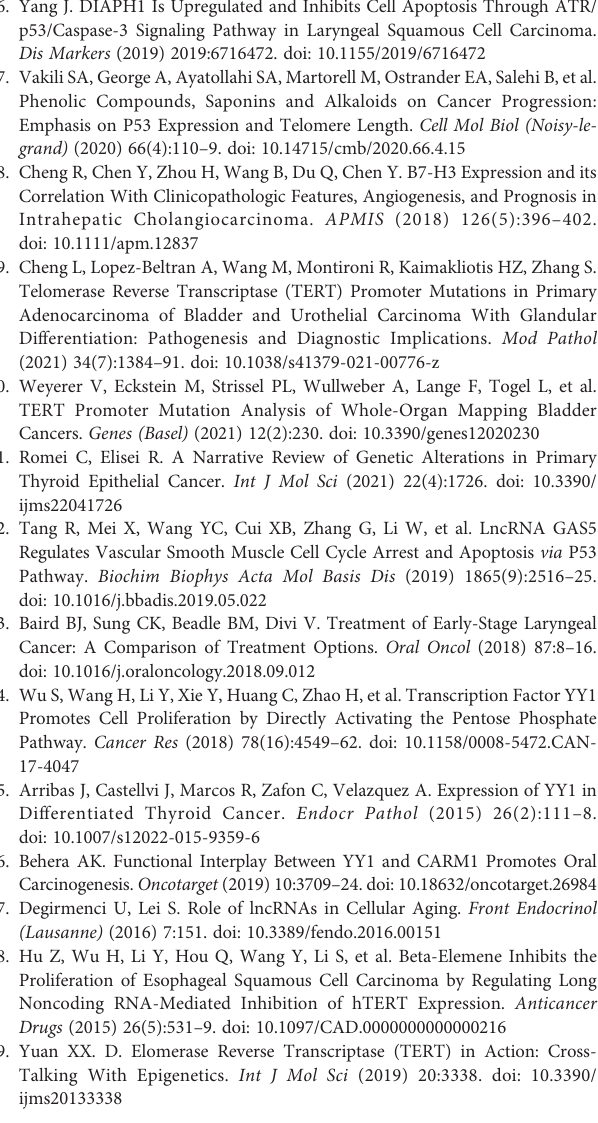
Supplementary Figure 3 | Veri fi cation of the correctness of TERT antibody. (A) RT-qPCR used to detect the expression level of TERT mRNA, * indicates p < 0.05 compared with NC. (B) The expression of TERT protein detected by Western blot. Supplementary Figure 4 | Co-IP results. (A) The interaction between GAS5, p300 and p53. (B) interaction between p300 and p53 after overexpression of YY1 and cGAS5. Supplementary Figure 5 | Representative images of FISH and Q-FISH assays. A, Subcellular localization of YY1 (green) and GAS5 (red) determined by FISH assay. Blue indicates DAPI staining. B, Telomere length of cells measured by Q- FISH. Blue indicates nucleus, red indicates telomere, and green indicates